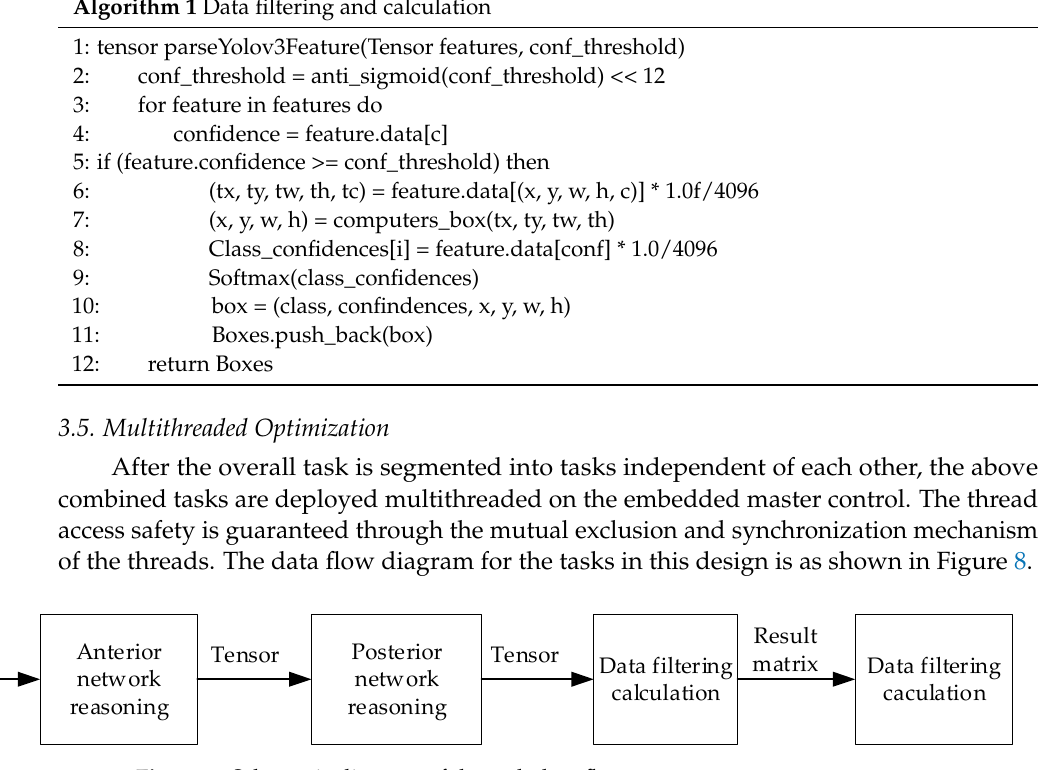
Figure 8. Schematic diagram of the task data flow.